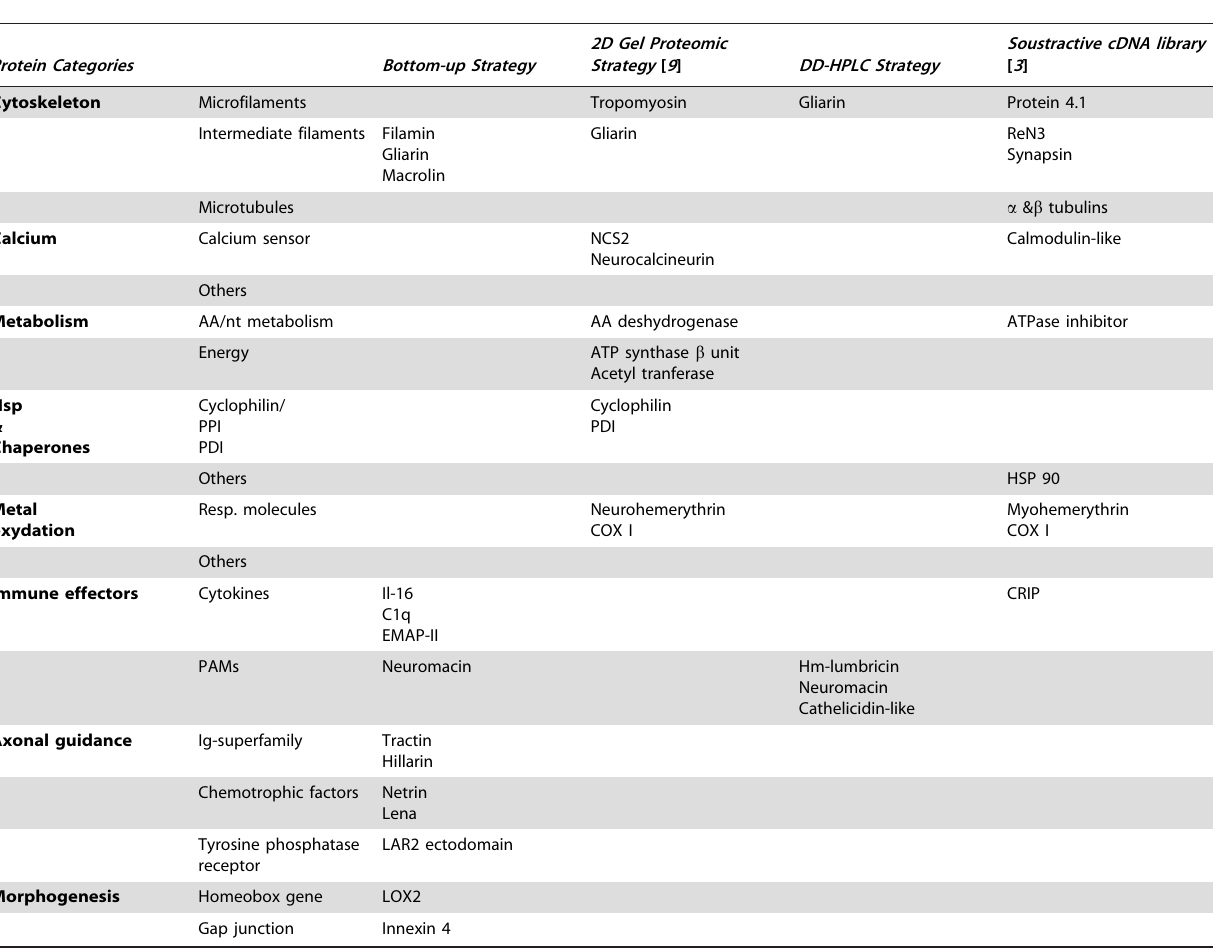
Table 3. Leech nerve cord proteins implicated in adult neuroregeneration using Proteomic (Bottom-up, DD-HPLC, 2D-Gel analysis) and Transcriptomic approaches.